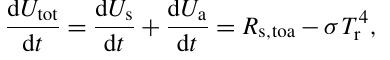
Figure 2. Schematic diagram of the surface energy balance used here in which turbulent heat fluxes are described as a result of an atmospheric heat engine operating between the surface and radia- tive temperatures. The limit to how much power can maximally be derived from this heat engine provides a means to parameterise tur- bulent heat